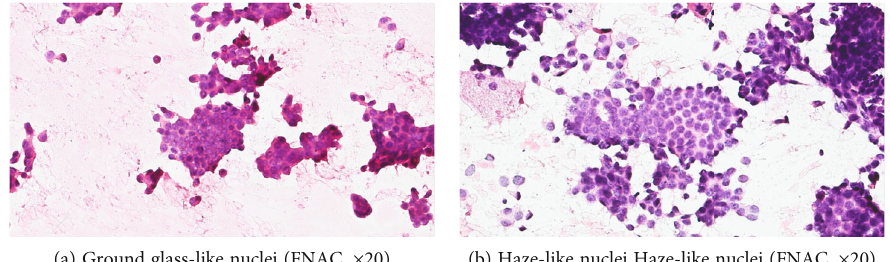
Figure 2: (a) Ground glass-like nuclei and (b) haze-like nuclei: nuclear membrane, light and homogeneous chromatin, micronucleoli (FNAC, × 20).